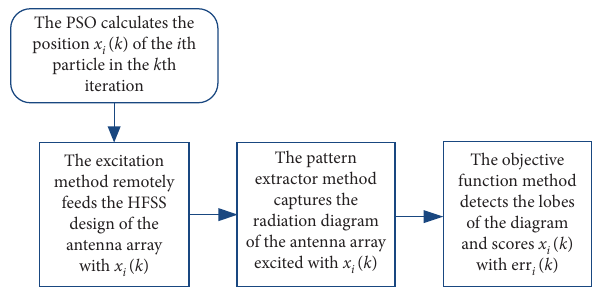
Figure 6: Flowchart of the algorithm process to remotely access the HFSS.